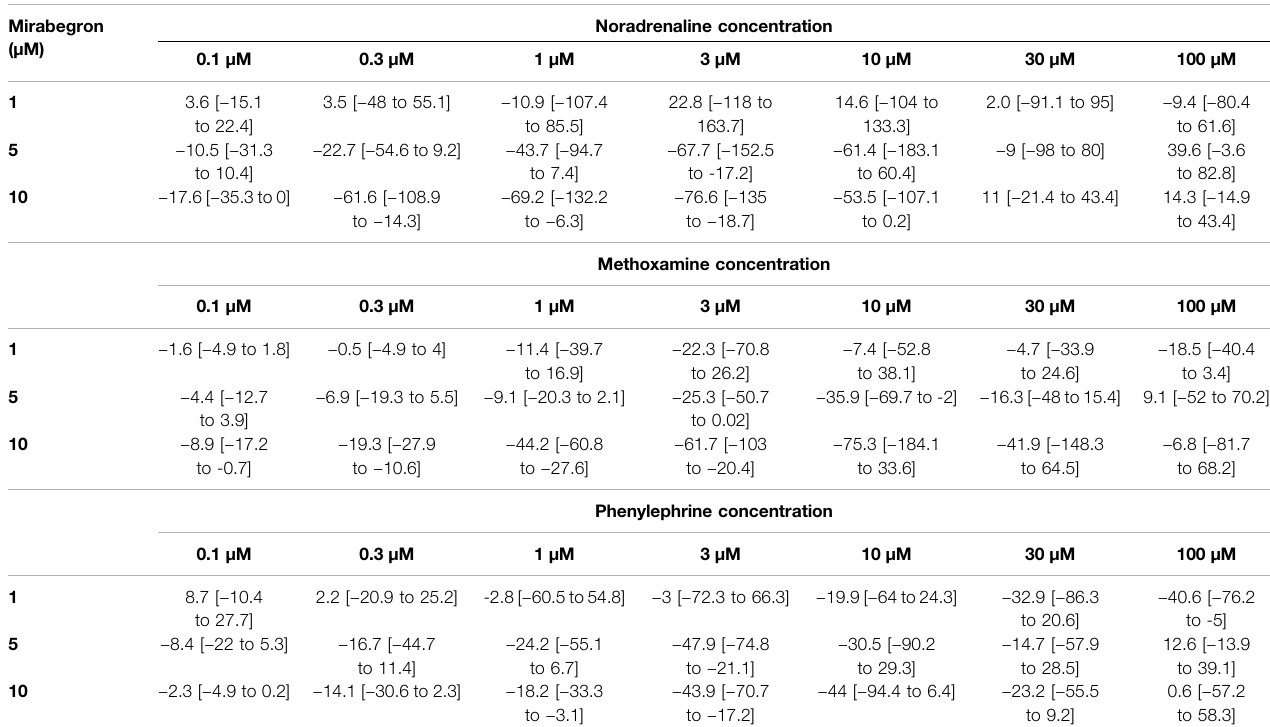
TABLE2| Meandifferences(MD)fornoradrenaline-,methoxamine-andphenylephrine-inducedcontractionsofhumanprostatetissuesafterapplicationofmirabegron(1,5, 10 μ M) or DMSO for controls, shown for each applied agonist concentration and with 95% con fi dence intervals (CI) (in square brackets, low to high) (% of KCl-induced contractions). Differences in contraction at given agonist concentrations were calculated for each single experiment (i. e., between mirabegron and control group, for corresponding, paired samples from the same prostate in each single experiment), and are expressed as MD with 95% CI. Mirabegron ( μ